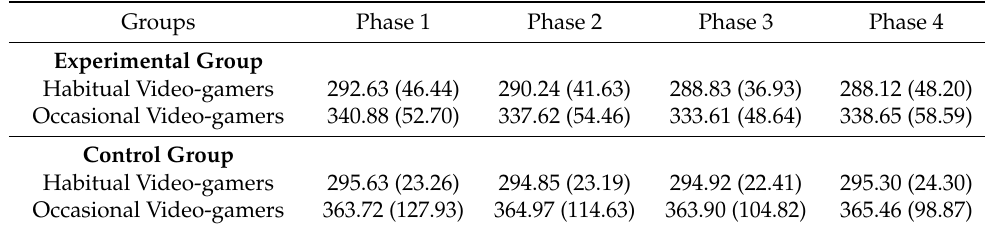
Table A3. Means (and standard deviations) of the RTs in the Aim Trainer Research Task.